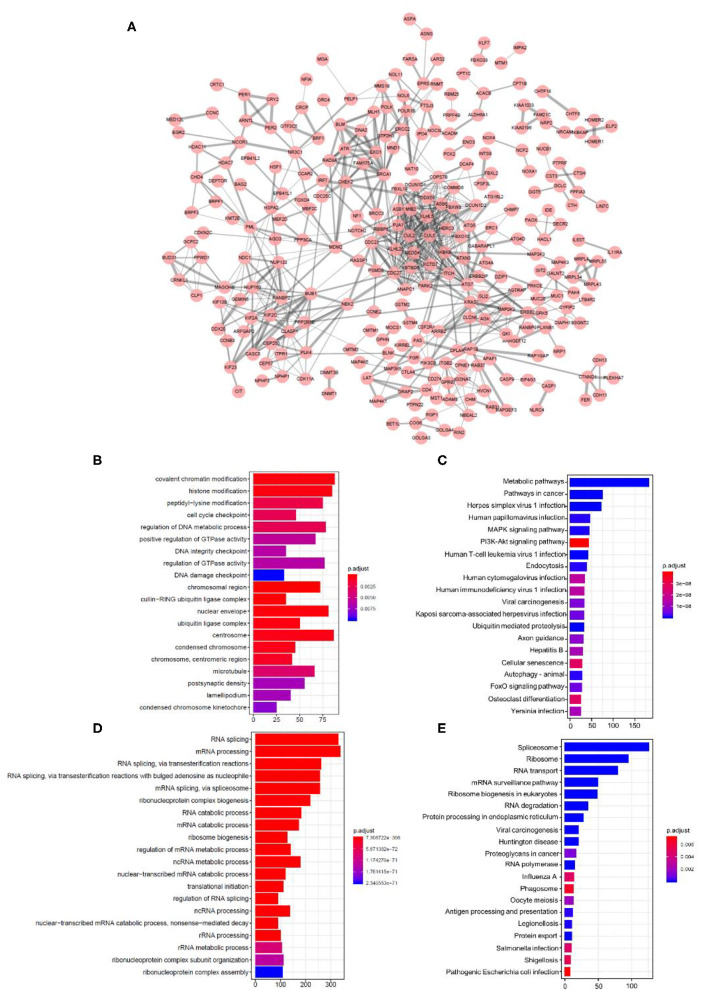
Construction of the protein–protein interaction network and functional enrichment analysis. (A) Protein–protein interaction network of spliced genes affected by RBP mutations. Red dots represent each spliced gene. Line thickness represents the strength of interaction. (B–E) GO and KEGG analysis outcomes of RBPs and spliced genes. The top 20 most significant enriched pathways were exhibited in a bar plot. (B,C) Enriched pathways in GO analysis, (B) KEGG analysis, and (C) spliced genes regulated by RBPs. (D,E) GO, (D) KEGG, and (E) enrichment analysis outcomes of RBPs.